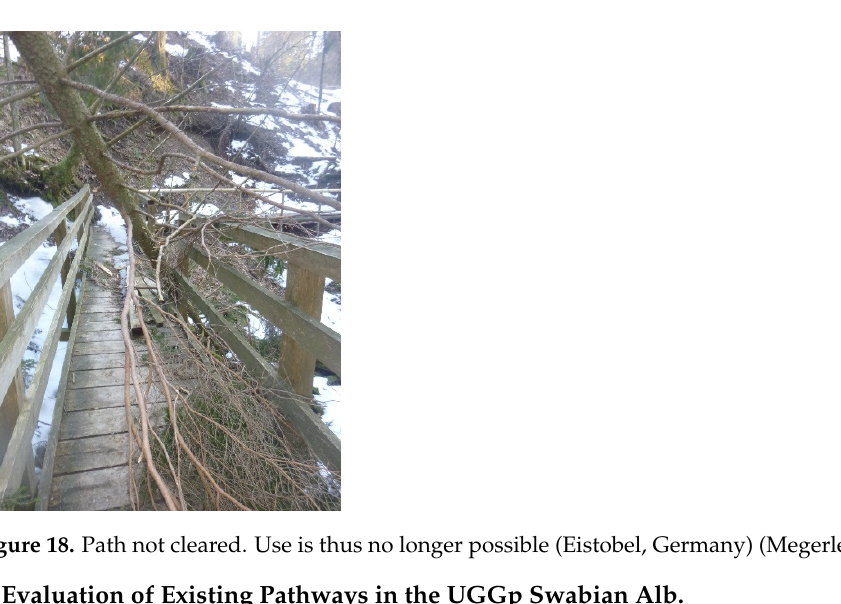
Figure 17. Path of Senses (Reutlingen, Germany). Text also in Braille (Megerle 2002).